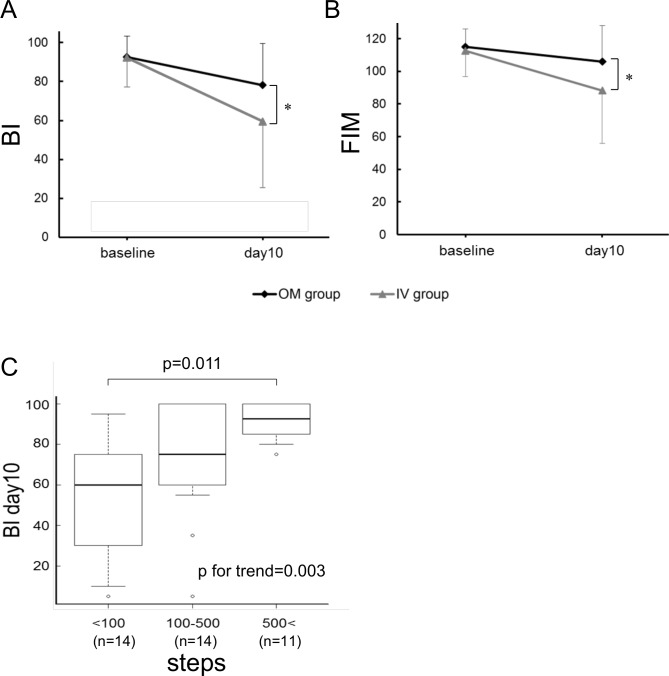
Changes in activities of daily living (ADL) scores after 10 days of hospitalization, and BI scores based on the number of daily steps.The Barthel Index (BI, A) and Functional Independence Measure (FIM, B) scores in the OM and IV groups are shown; *P < 0.05. The BI score at day 10 according to the number of daily steps is shown (C).